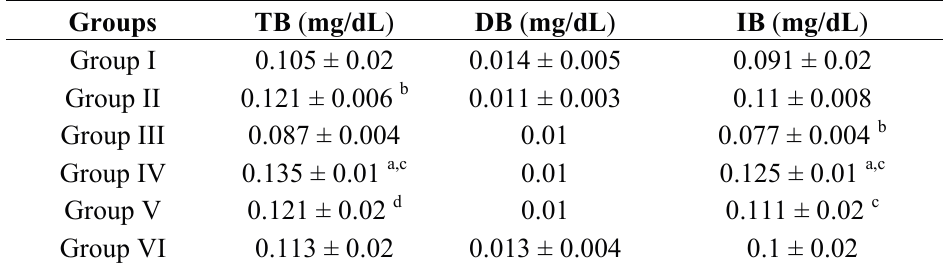
Table 8. Bilirubin values.